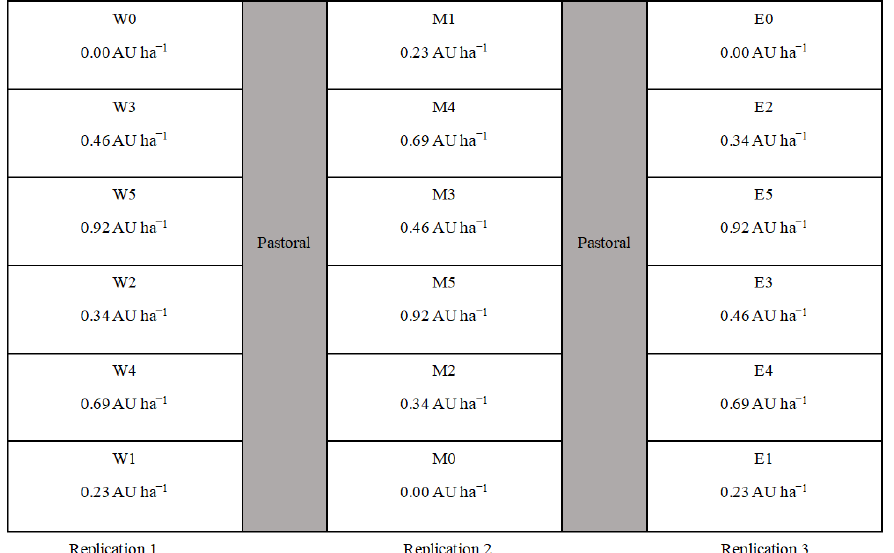
Figure 1. Diagram of different grazing intensities. Note: The upper letter is the “test plot number”, where W-west, M-middle, E-east; the lower numbers and letters are “livestock grazing intensity”. Table 1. Changes in the species composition of functional groups under different grazing intensi- ties.